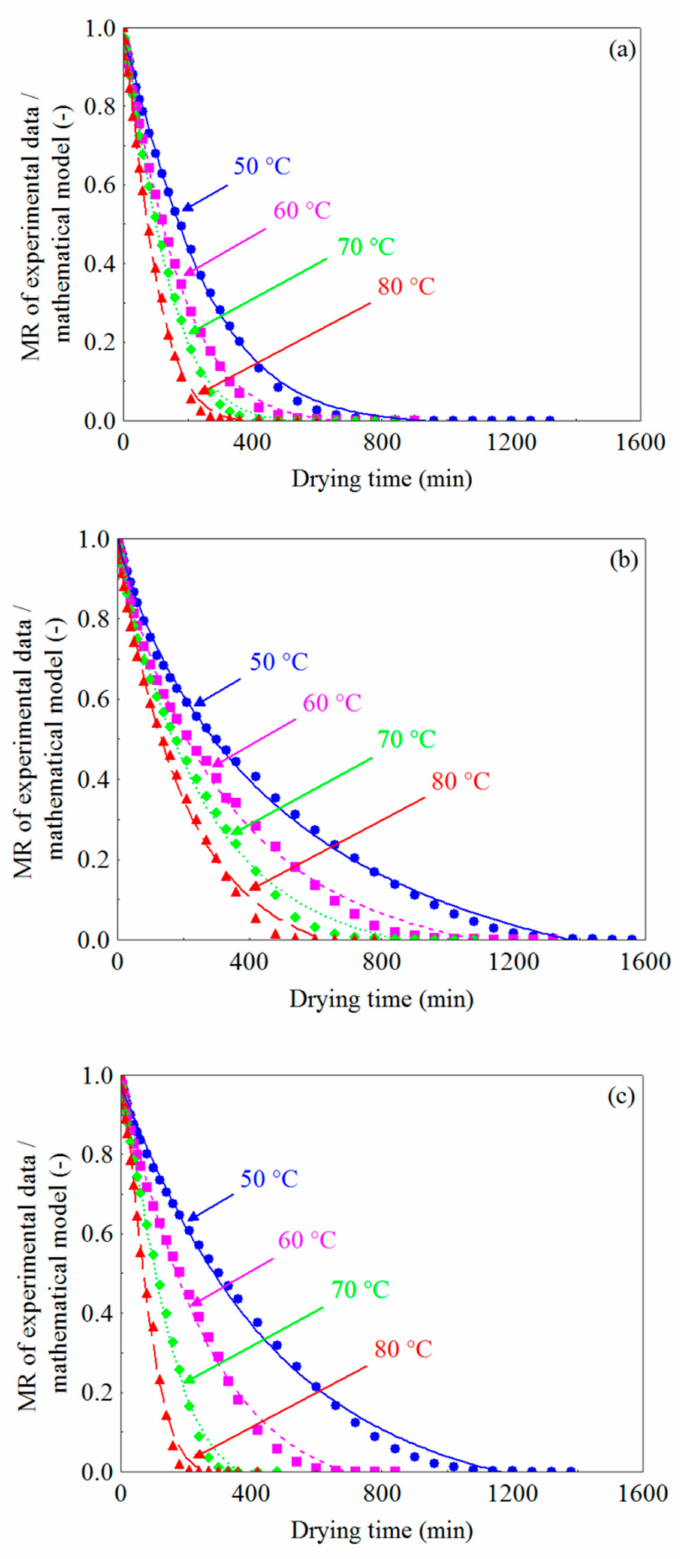
Figure 5. Comparison of dimensionless moisture contents obtained experimentally and predicted using the Midilli mathematical model at temperatures of 50–80 ◦ C for ( a ) WR, ( b ) CR and ( c ) FR: ( ) Experimental data, ( ) Model, ( ) Experimental data, ( ) Model, ( ) Experimental data, ( ) Model, ( ) Experimental data, ( )